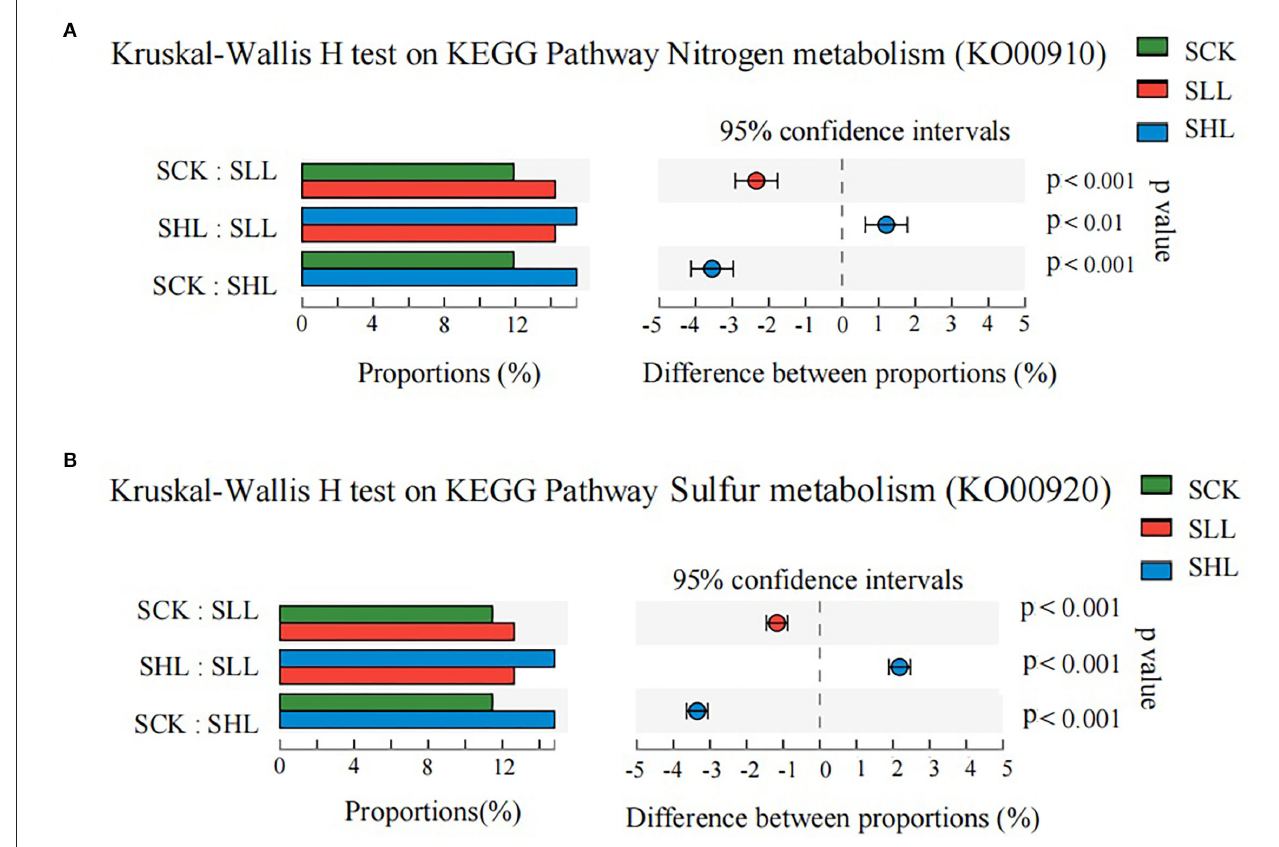
FIGURE 7 | The relative abundance of predicted genes related to nitrogen metabolism (KO00910) (A) and sulfur metabolism (KO00920) (B) showed significant differences among HLB-infected citrus rhizoplane soil samples. SCK, soil without lime treatment; SLL, soil treated with low-level lime; SHL, treated with high-level lime. Differences were considered significant at p < 0.05 by the Kruskal Wallis H